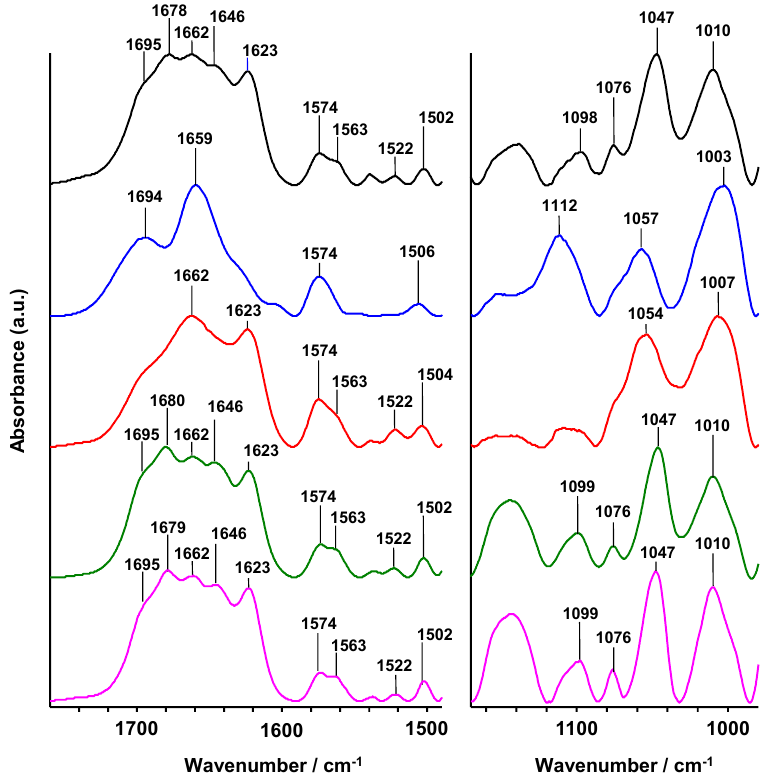
Figure 2. IR spectra of Li28 solubilized in D 2 O: at pH = 7.5 (black line); at pH = 2.5 (blue line); submitted to pH = 2.5 for 30 min before addition of NaOH to adjust the pH to 7.5 (red line); after acidic condition, readjustment at pH = 7.5 and then desalting process (green line); and after release from NP surface at a ratio R = 70 and desalting process (purple